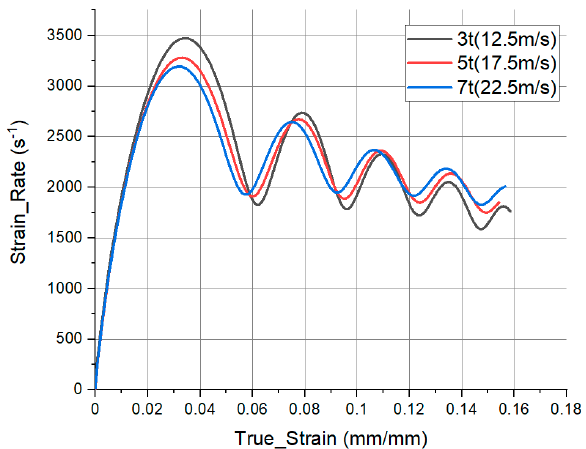
Figure 12. Comparison of the strain and strain rate results under different test conditions.